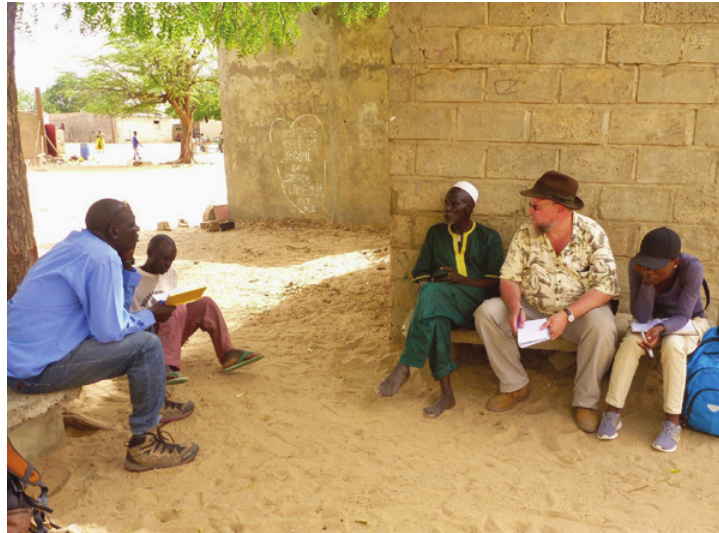
Figure 1 Kevin undertaking an interview of a town elder at Dialakhar, Senegal, with Professor Ibrahima Thiaw (IFAN) and Aïcha